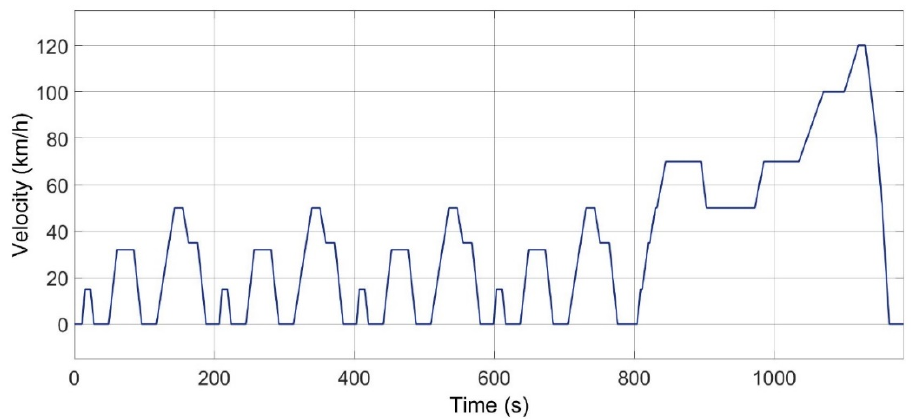
Figure 10. New European Driving Cycle (NEDC).